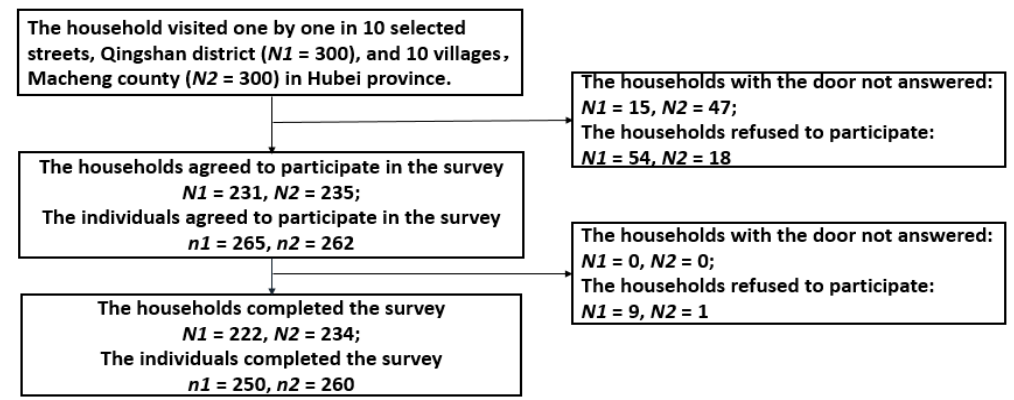
Figure 1. Recruitment of Survey